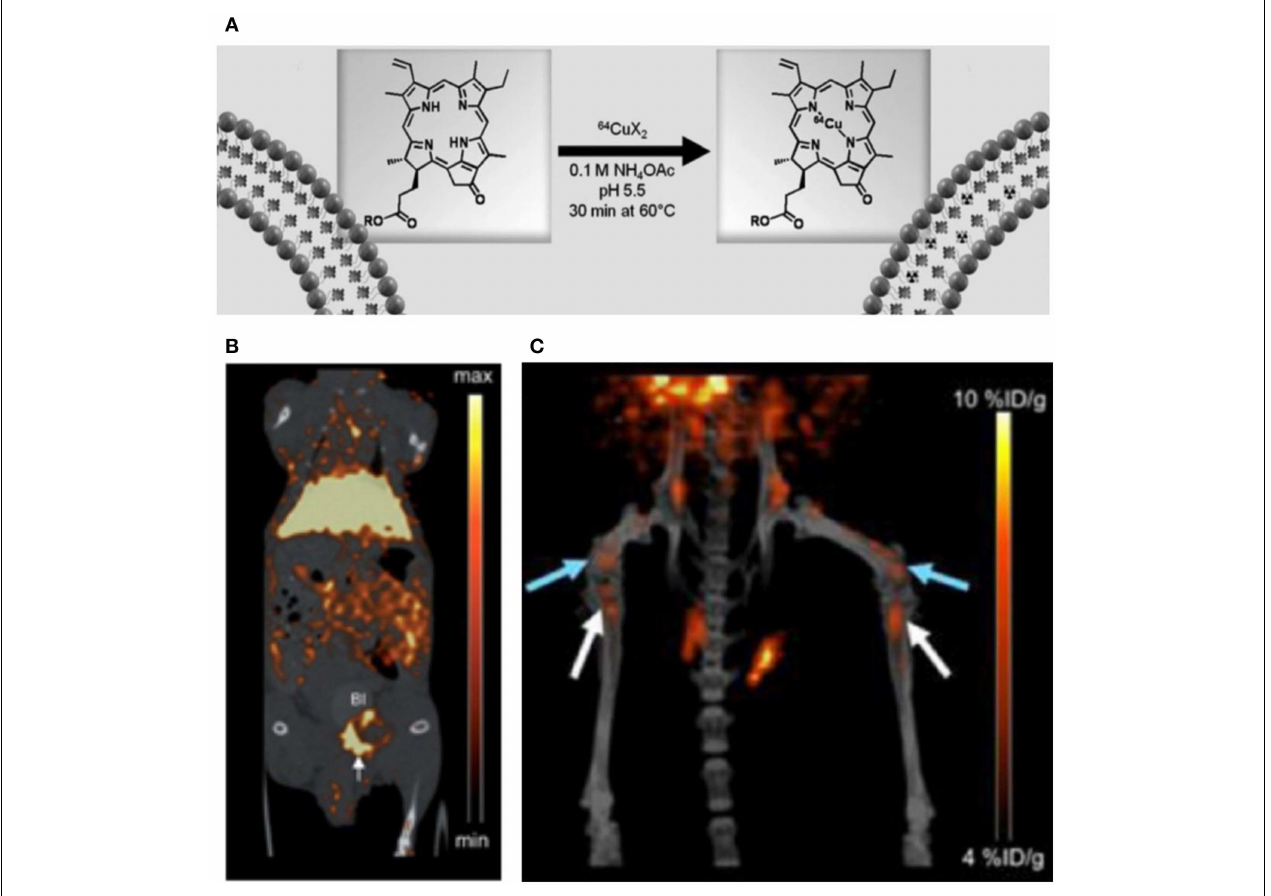
(C) 3D MicroPET/CT images (blue arrow, distal femur metastases, white arrow, proximal tibia metastases) (Adapted with permission from Liu et al. [15, 106]).